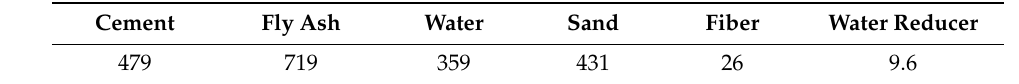
Table 3. Mix design (kg / m 3 ).